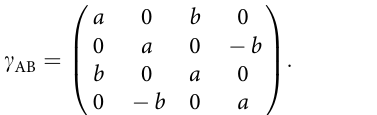
entangled state, whose modes are labelled as A 1 , B 1 , and A 2 , B 2 , respectively. Modes A